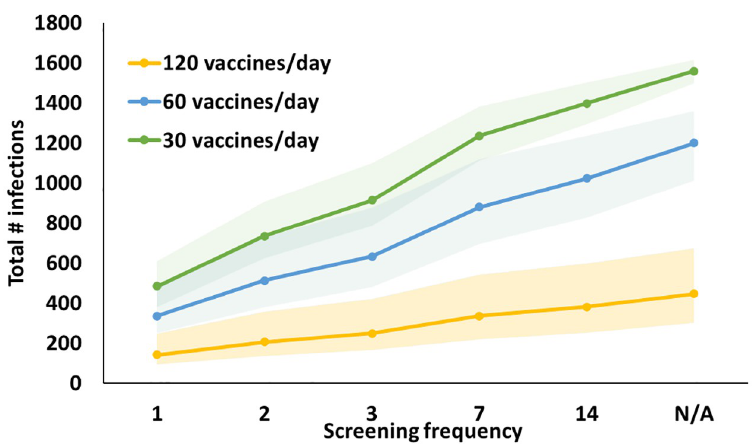
Fig 1. Total number of infections versus screening frequency for three daily vaccination rates, indicated by color, for 60% initial campus-wide vaccine coverage ( L s = L f = 60%) and 75% compliance ( η = α = 75%) in the base-case scenario with full screening. Each shaded region depicts the uncertainty region resulting from varying levels of screening and vaccination compliance (60%, 75%, 90%), test sensitivity (70%, 80%) and specificity (98%, 99.7%). N/A represents “no